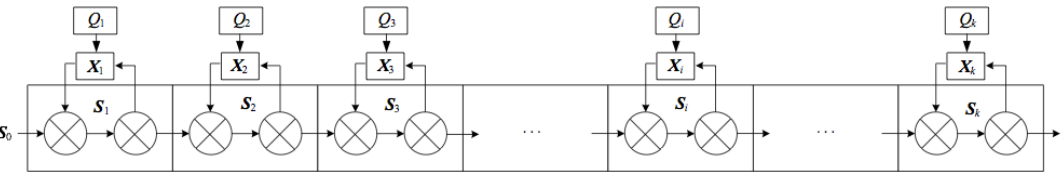
Figure 3. Topological decomposition scheme for the optimization of the drying process using discrete dynamic programming. State variables are indicated with S i , control variables (temperatures and flow rates of the heating gas) with X i , and the objective function at each cell with Q i . Both forward and backward steps are shown.